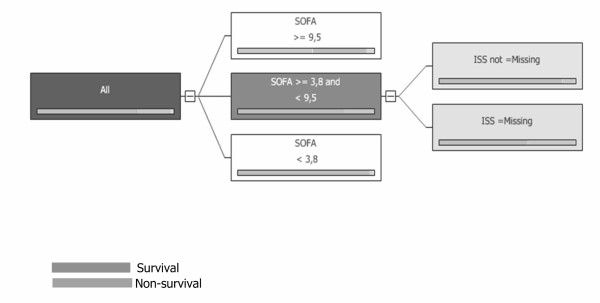
The DTM results.